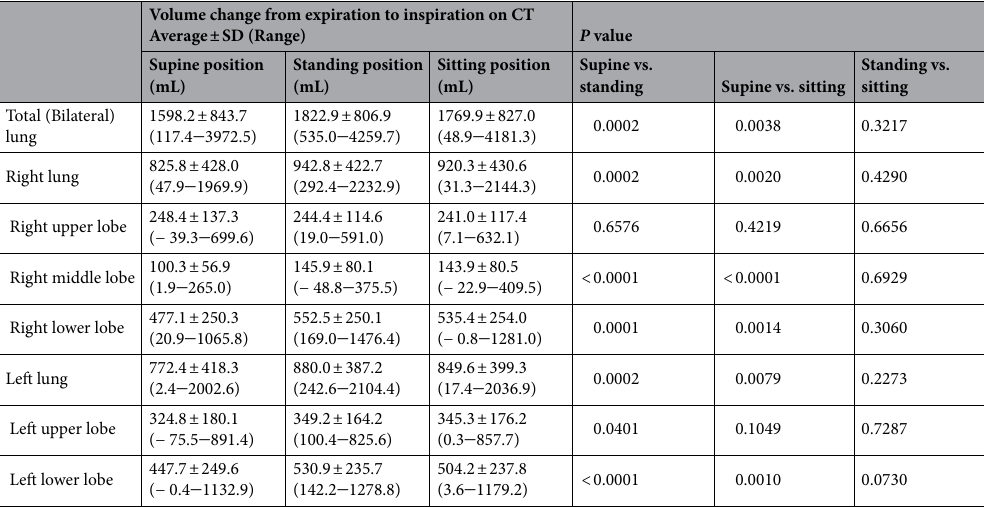
Table 4. Lung and lobe volume changes from expiration to inspiration as determined using CT in the supine, standing, and sitting positions (100 volunteers). P < 0.0167 was considered to be statistically significant, with Bonferroni correction for multiple